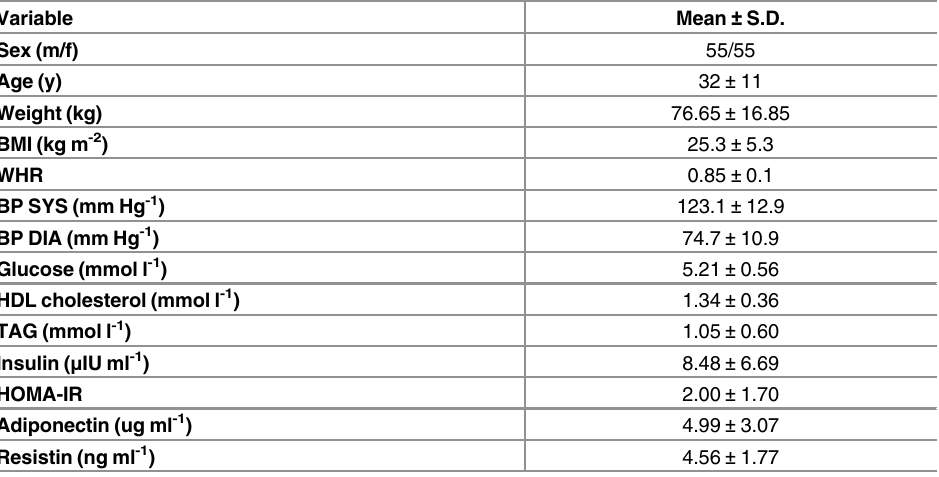
Table 1. Baseline characteristics of MECHE cohort (n = 110).